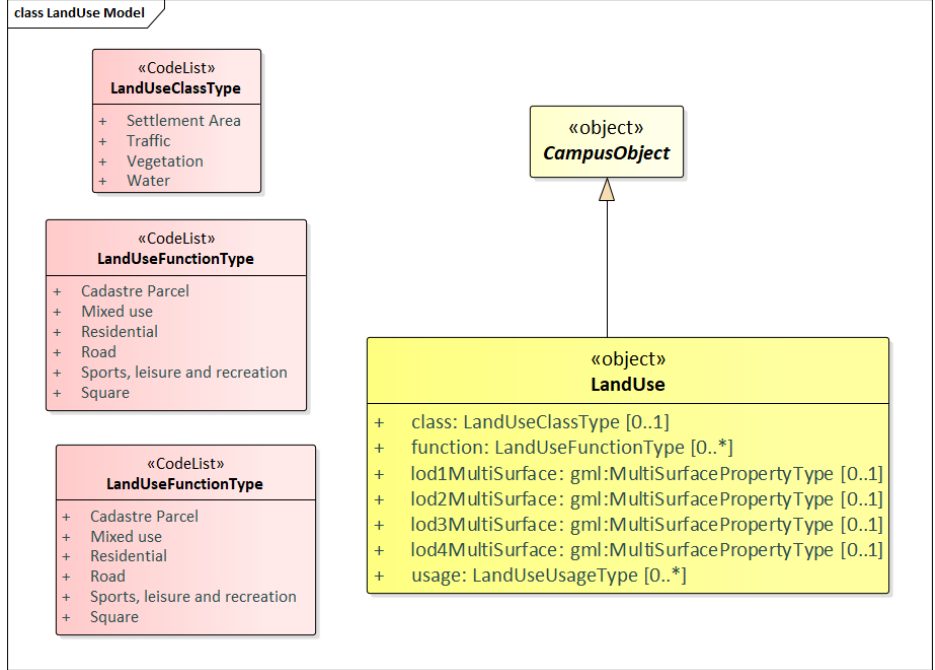
Figure 10. UML diagram of land use